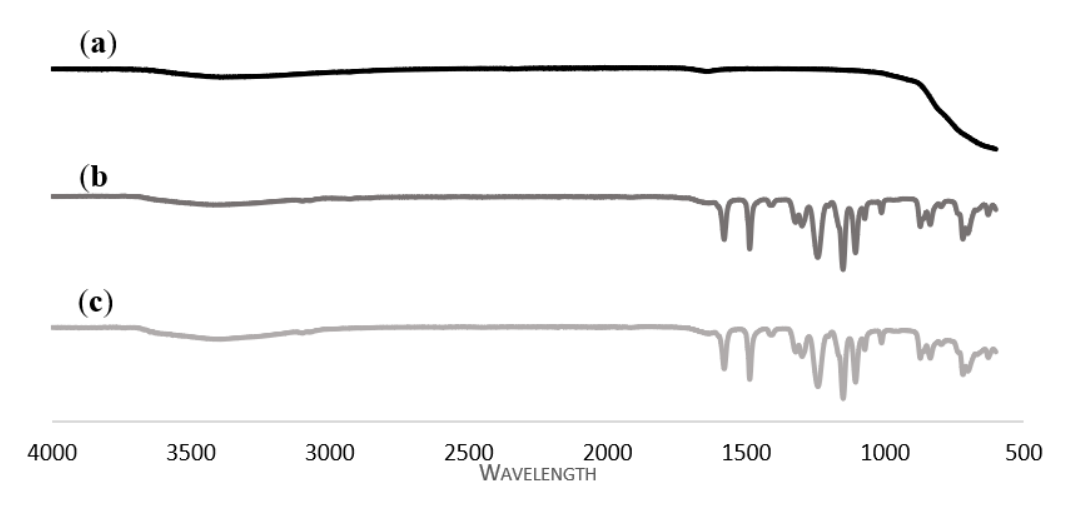
Figure 3. ATR-FTIR spectra of ( a ) TiO 2 photocatalyst; ( b ) a neat PES membrane; and ( c ) a TiO 2 /PES mixed matrix membrane.